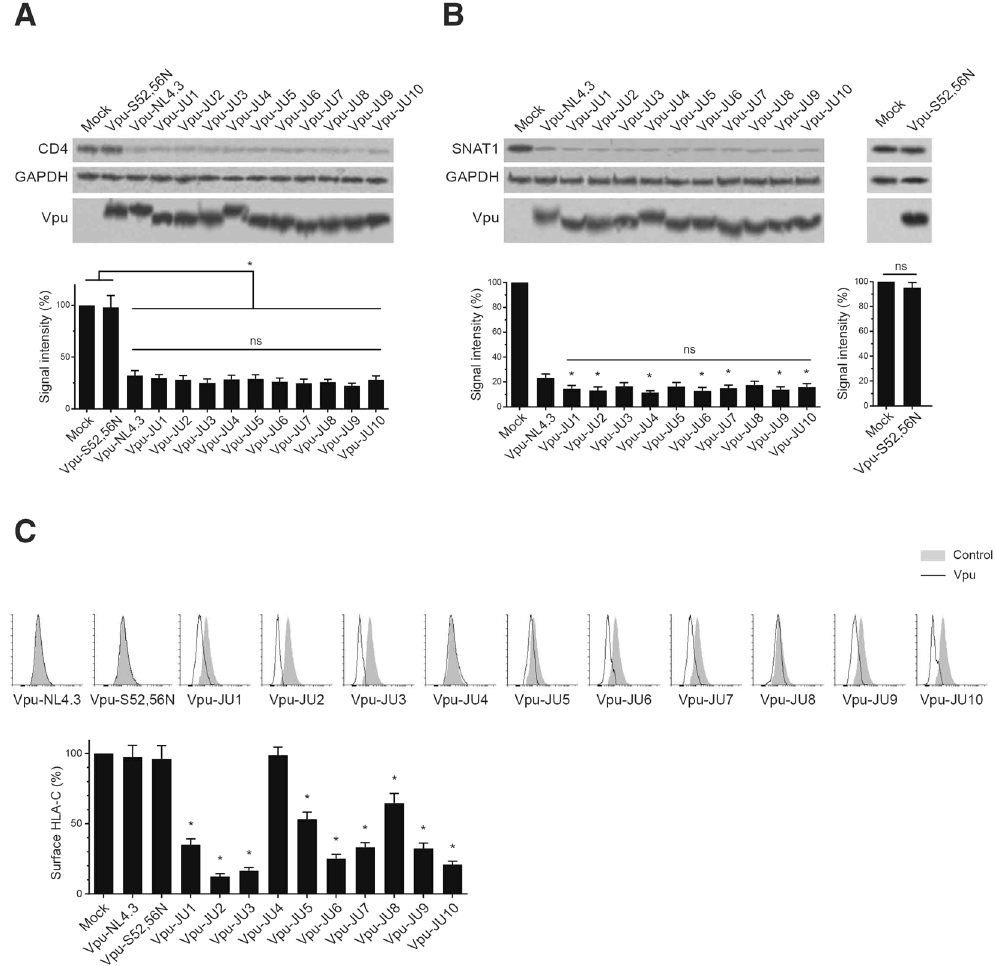
Figure 2. Downregulation of cellular proteins by HIV-1 Vpu alleles. ( A ) CEM-CD4 + cells were transduced with GFP-marked lentiviral vectors expressing Vpu alleles. A mutant form of Vpu (Vpu-S52, 56N), incapable of downregulating CD4, was used as control. After 48 h, transduced cells were sorted using the GFP signal and subjected to Western blot to assess CD4 expression level by Vpu alleles (n = 3). ( B ) CEM-CD4 + cells were transduced with GFP-marked lentiviral vectors expressing Vpu alleles. GFP-positive cells were sorted after 48 h and analyzed using Western blot to assess downregulation of SNAT1 by Vpu alleles (n = 3). Asterisks indicate significant differences of subtype A Vpu alleles compared with NL4.3 Vpu. ( C ) Vpu alleles were tested for their ability to downregulates HLA-C on the cell surface of CEM-CD4 + cells transduced with GFP-marked lentiviral vectors. The bar graph shows summary of 3 independent experiments. Asterisks indicate significant differences of subtype A Vpu compared with NL4.3